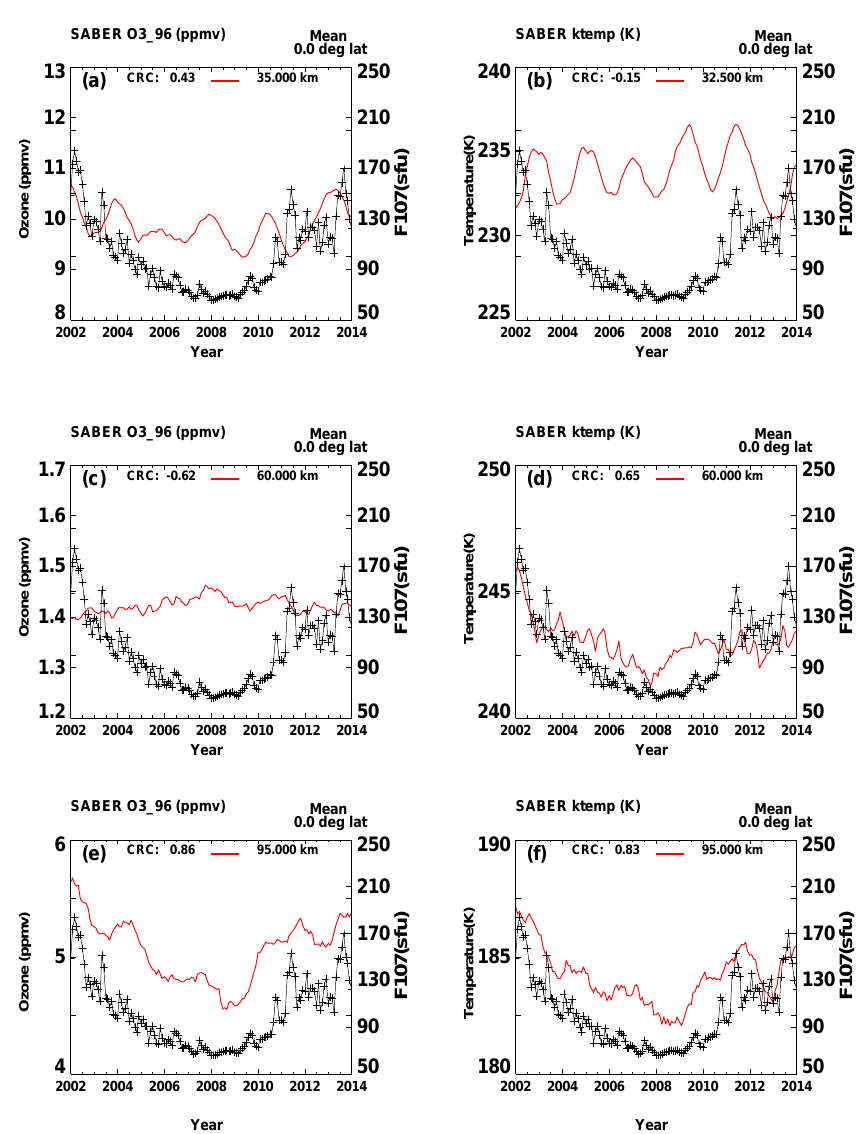
Figure 1. Top row: ozone zonal mean mixing ratios (left panel, red line, ppmv) from mid-2002 to mid-2014 at 35km and 0 ◦ lat; right panel, as in left panel but for temperature (K) at 32.5km. Middle row: as in top row but at 60km. Bottom row: 95km. Black lines ( + , right scale) show the corresponding monthly 10.7cm flux (sfu) provided by